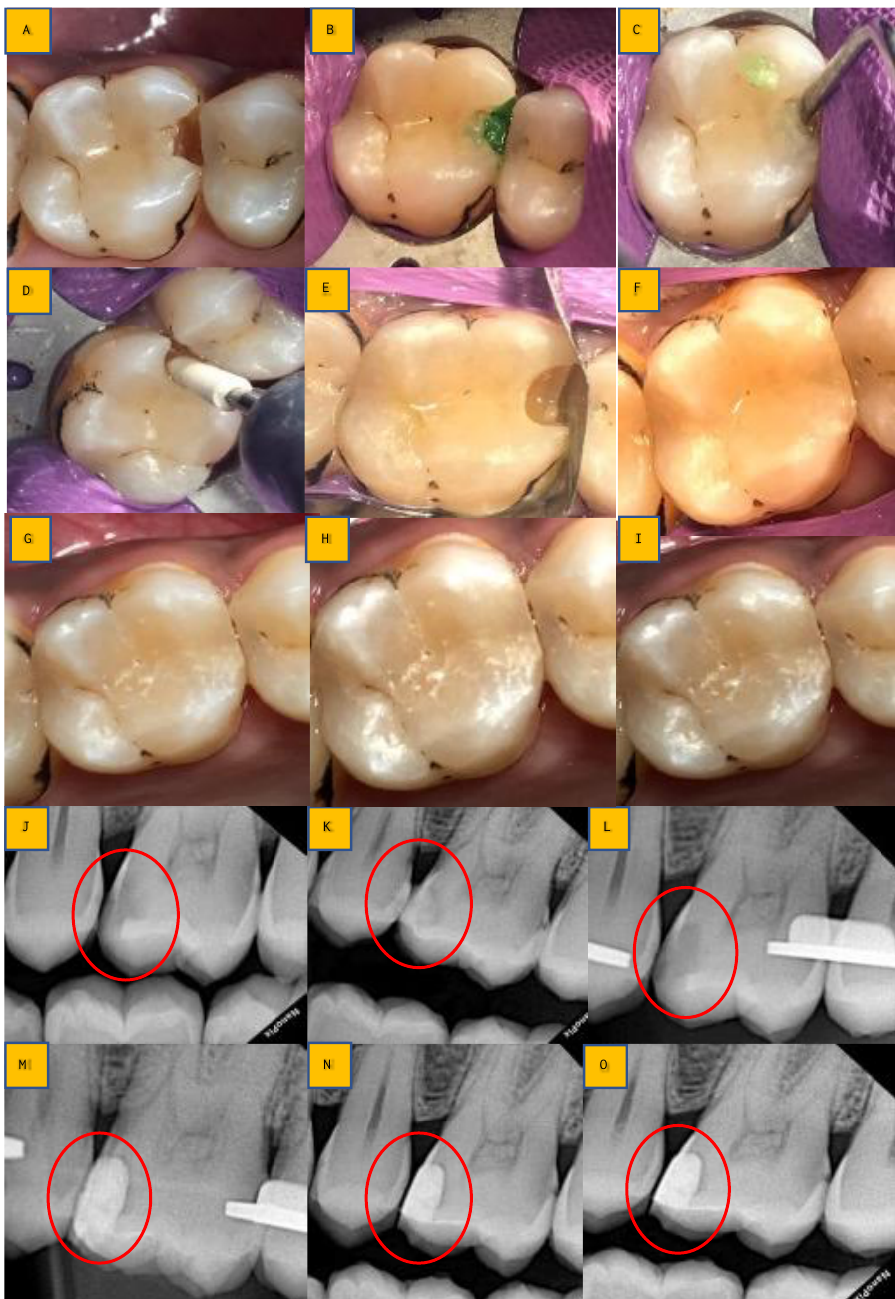
Figure 5. Clinical steps for the proximal caries group (BCD group): ( A , J ): preoperative clinical photo and radiograph (red circle); ( B , C ): application of BCD solution; ( K ): extension of radiopaque BCD solution seen on radiograph (red circle); ( D , E ): caries excavation with spoon excavator and finishing with Arkansas stone; ( F , L ): post-caries excavation clinically and radiographically (red circle); ( G , M ): cavity restored with composite material and immediate post-restoration radiograph (red circle); ( H , N ): post-restoration clinical photo and radiograph (red circle) after 3 months; ( I , O ): post-restoration clinical photo and radiograph (red circle) after 6 and 12 months.